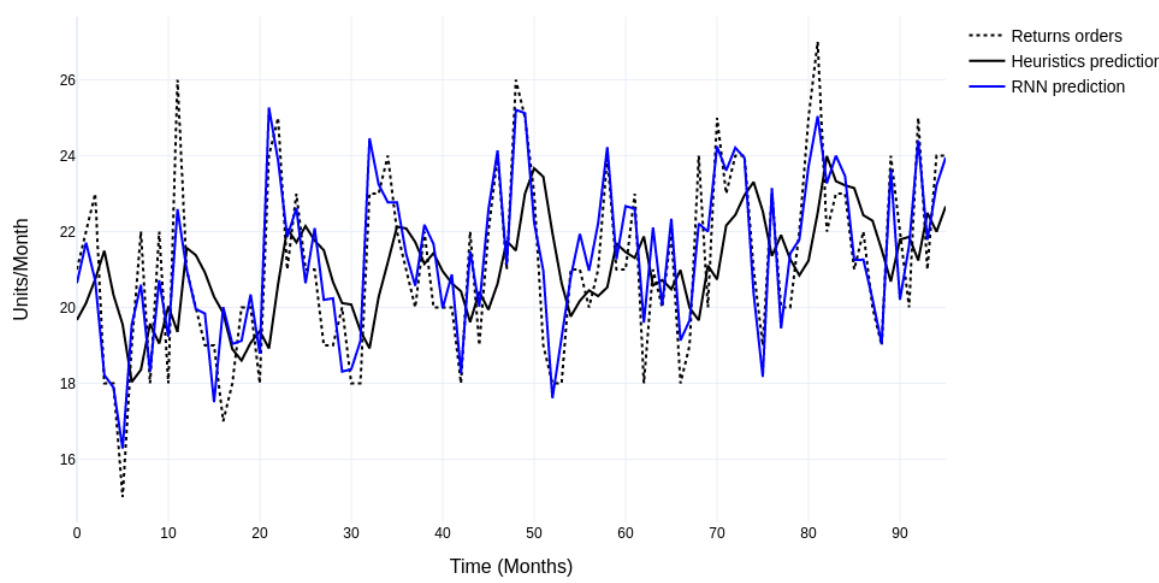
Figure 8. Comparing heuristic and RNN returns predictions.